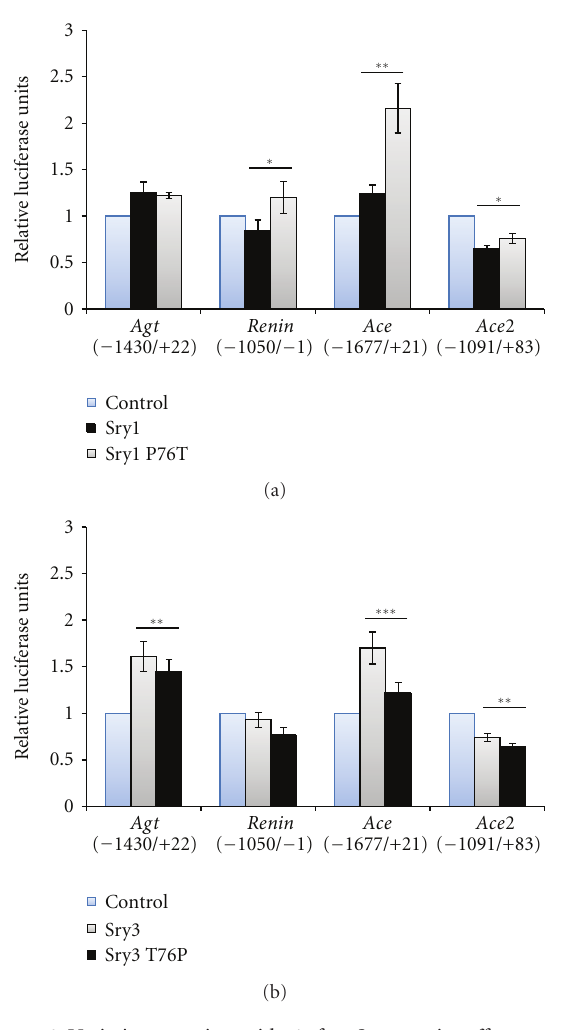
Figure 2: Variation at amino acid 76 of rat Sry proteins e ff ects on rat RAS gene promoters. Amino acid variation between Sry1 and Sry3 results in di ff erential activity on promoters of the RAS with Sry1 P76T (a) and Sry3 T76P (b). (a) Sry1 P76T significantly increased activity on Ren, Ace , and Ace2 . (b) Sry3 T76P significantly decreased activity on Agt , Ace , and Ace2 . Asterisks indicate significance from respective nonmutant Sry. ∗ P ≤ 0 . 05, ∗∗ P ≤ 0 . 01, ∗∗∗ P ≤ 0 . 001. Blue bars are the control pEF-1 vector and black bars represent proteins with a proline at amino acid 76.